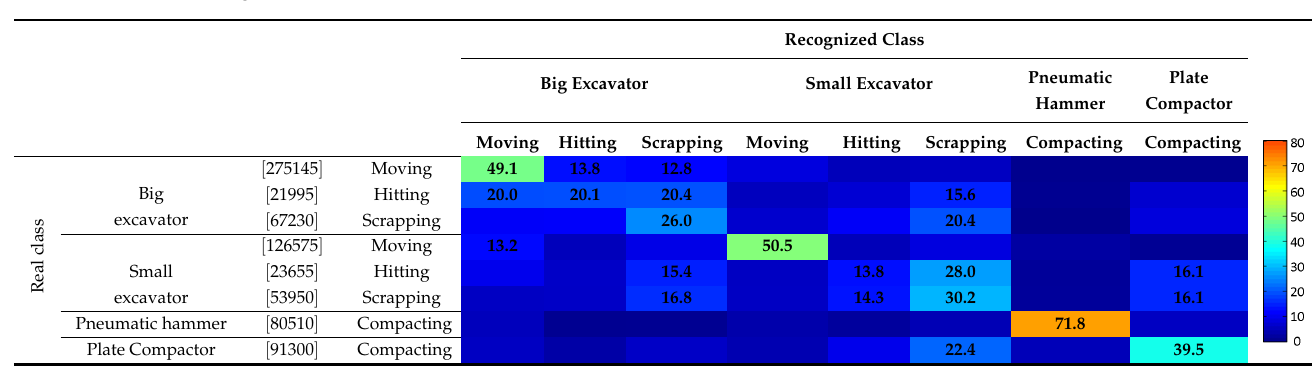
Table 5. Confusion matrix of the multi-position approach for detecting threats to the pipeline integrity for N = 1 position- based GMM training for the machine + activity identification mode (which represents the single-position approach chosen as baseline [26]). Each cell contains the classification accuracy. The values shown between brackets denote the number of frames that belong to the real